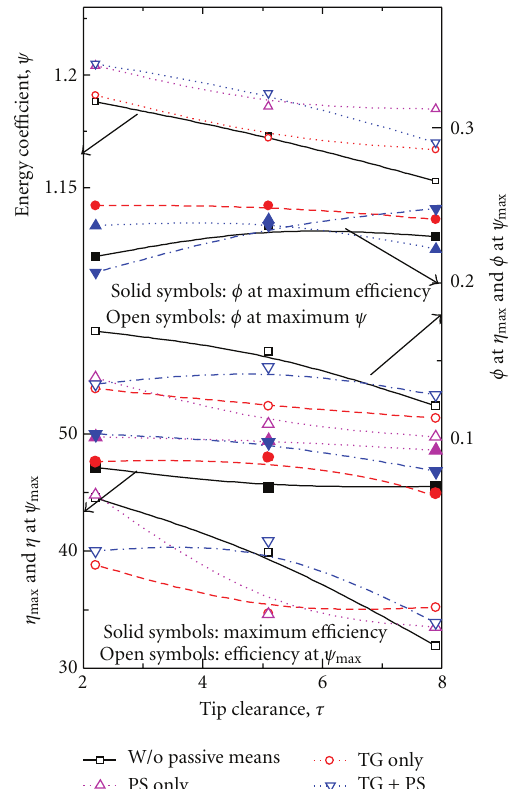
Figure 7: E ff ect of tip clearance on performance.